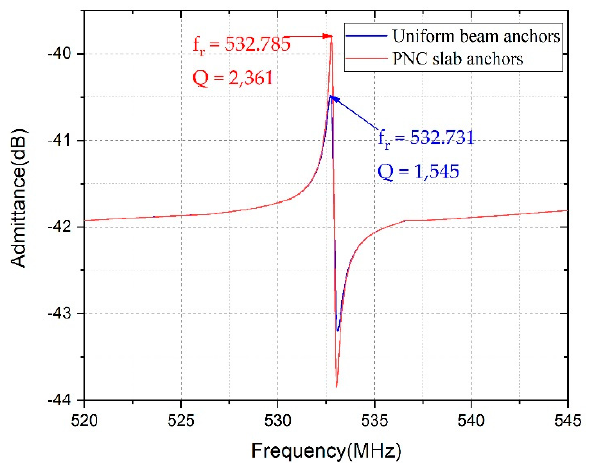
Figure 9. The admittance curves of the LWR with uniform beam anchors and PnC slab anchors.